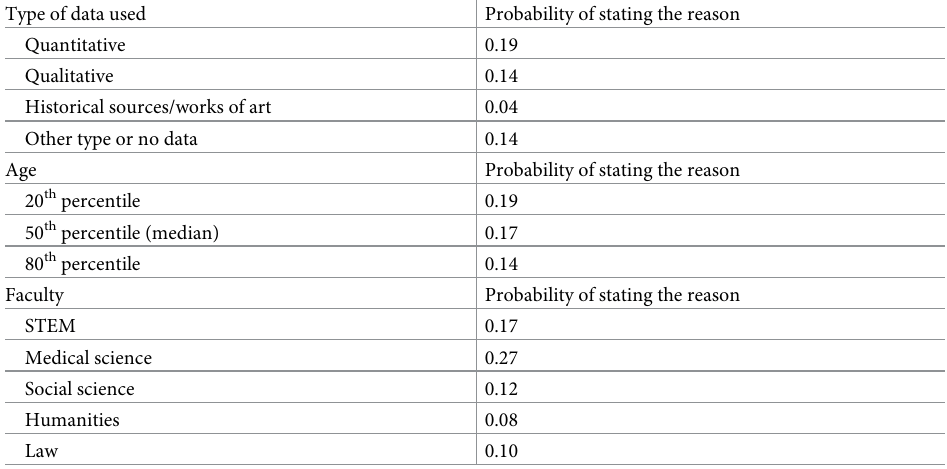
Table 10. Share of PhD students (predicted probabilities) who granted a guest authorship because “The person in power told me to” ( n = 1,096). Type of data used